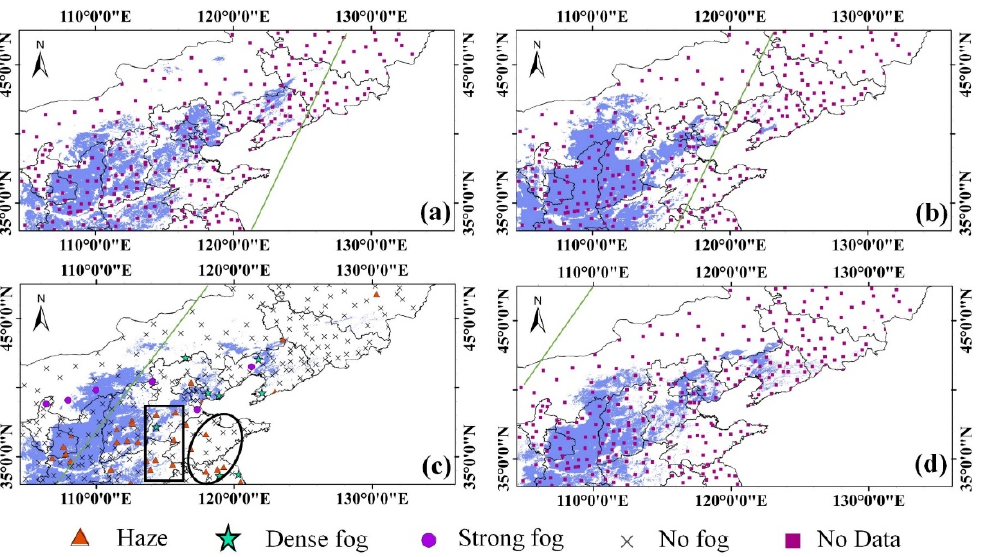
Figure 6. The fog detection results at ( a ) 7:00, ( b ) 7:30, ( c ) 8:00 and ( d ) 8:30 on 18 November 2016. The triangle, star, circle, and cross symbols represent haze, dense fog, strong fog, and non-fog stations, respectively. The square symbol indicates that there is no observation data because of the limit monitoring frequency. The blue area is the fog detected by our algorithm. All the times are at the Beijing Time (8 h later than the Universal Time Coordinated (UTC)) and the green line is the terminator line.